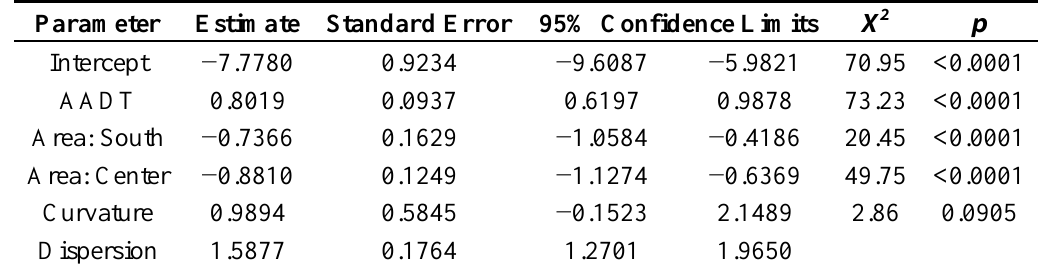
Table 2. GENMOD procedure results for the control model (one-third of the data for segments of 500 m in